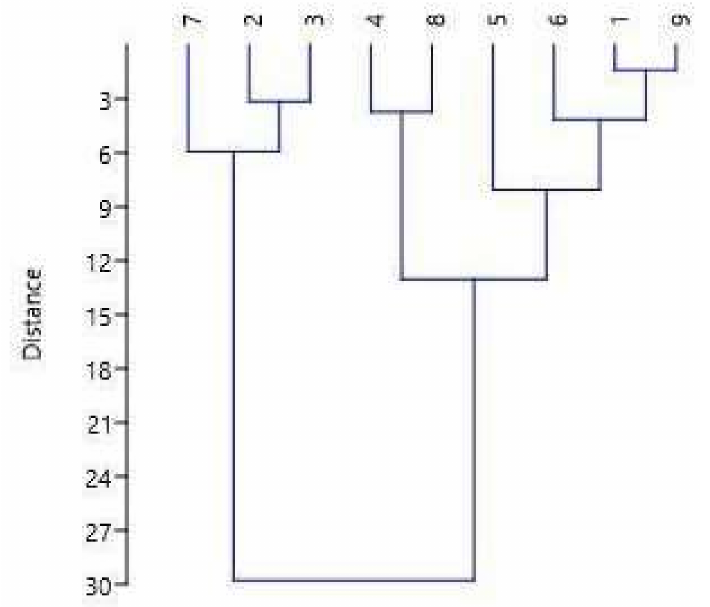
Figure 7. Hierarchical clustering based on the molecular composition of HAs. Ward’s